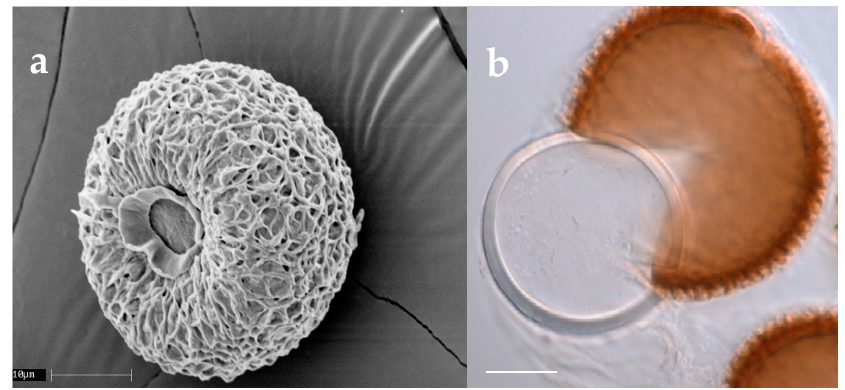
Figure 4. Resting spores of Zoophthora independentia (~44.5 μ m diameter) [15]. ( a ) Scanning electron micrograph illustrating the surface of the opaque epispore. ( b ) Light microscope photo illustrating an epispore detached from the smooth, hyaline endospore within. Scale bars are 10 μ m.